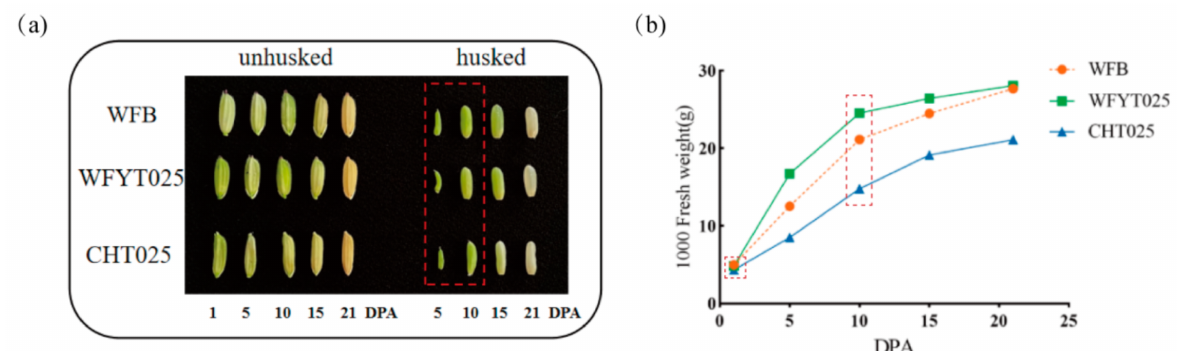
Figure 2. ( a ) Physical measurements show variation in the average unhusked/husked seed size of the dry seed of WFYT025 and its parents in five stages of seed development. U: Unhusked seed, H: Husked seed. ( b ) 1000-grain fresh weight of WFYT025 hybrid combination at various stages after